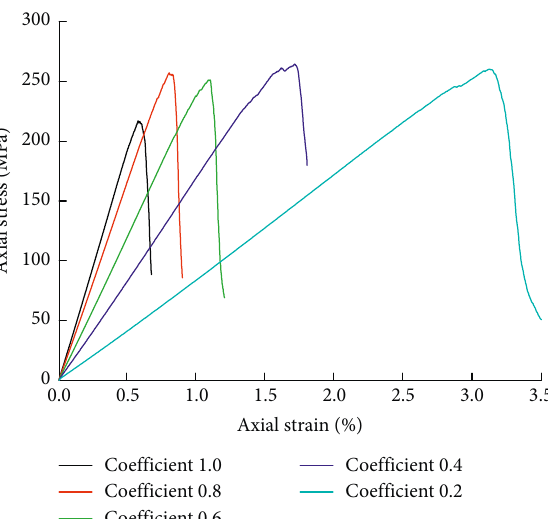
Figure 8: Axial stress-strain curves from uniaxial compression tests for the different coefficients of E ∗ .